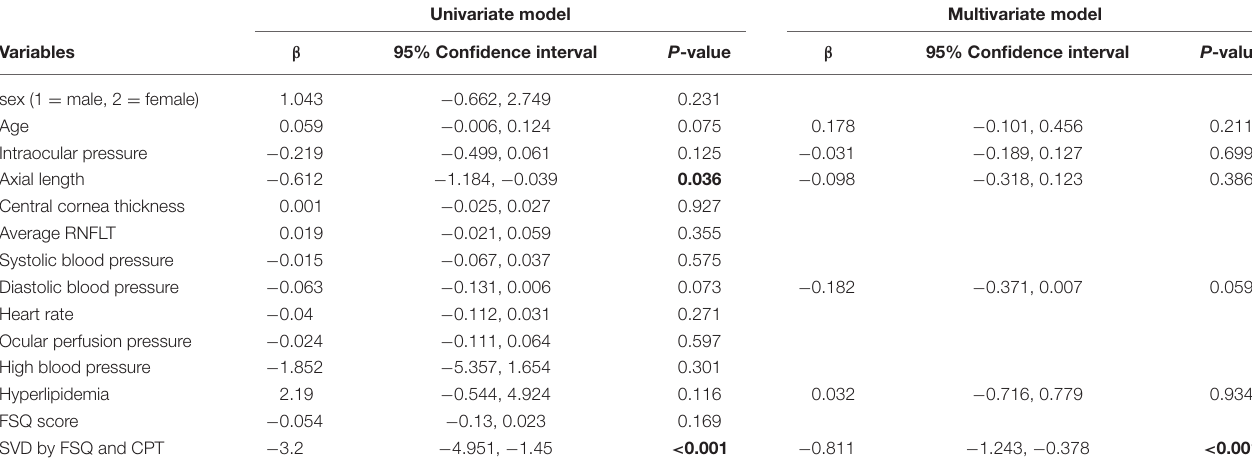
TABLE 4 | Univariate and multivariate generalized estimation equation analyses for factors associated with RPC vessel density in the superotemporal sector. Univariate model Multivariate model